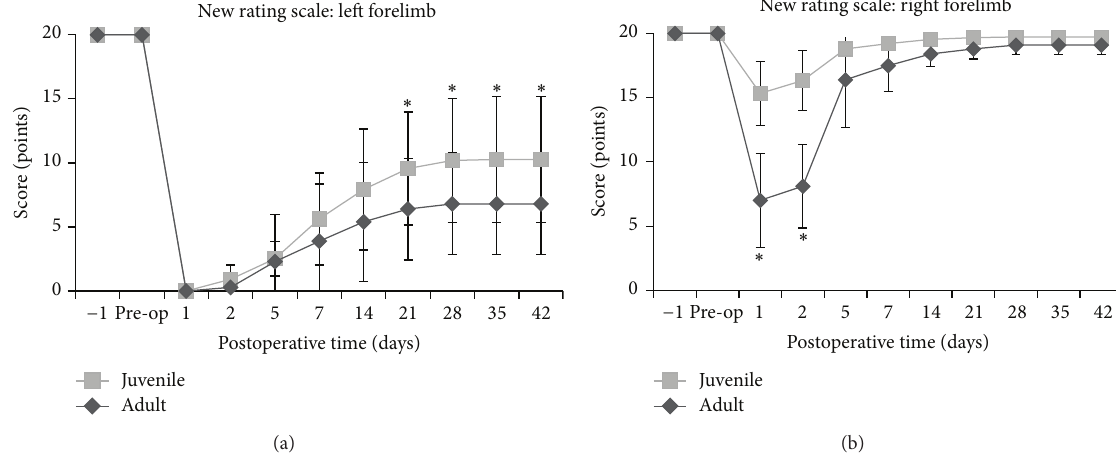
Figure 6: New Rating Scale scores in juvenile and adult rats. The New Rating Scale of the left forelimb shows that juvenile rats recovered significantly more than adult rats from day 21 ( ∗ 𝑃 < 0.05 ). In contrast, the New Rating Scale of the right forelimb illustrates that no significant difference was seen between juvenile and adult rats from day 5.